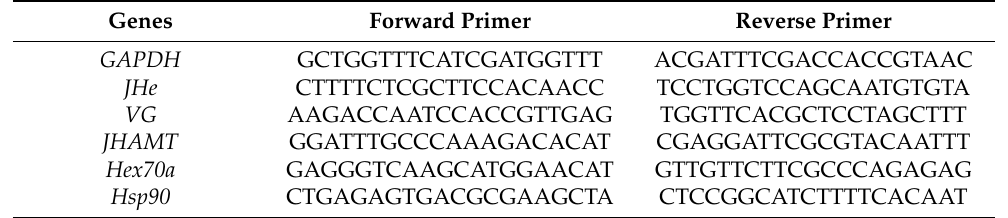
Table 1. Primer sequences for quantitative